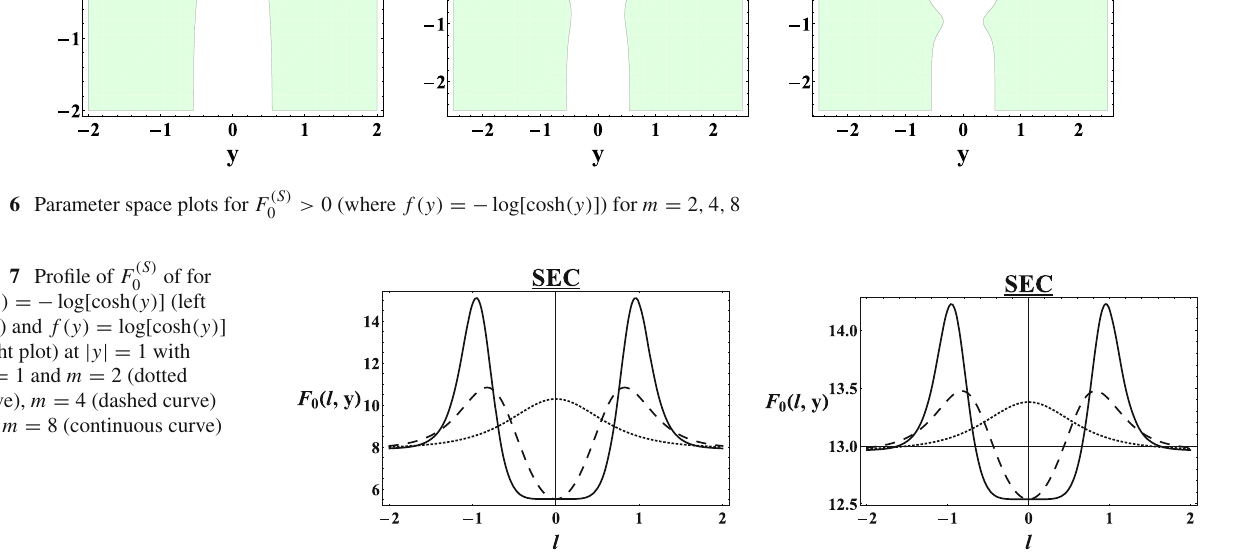
Fig. 6 Parameter space plots for F ( S )